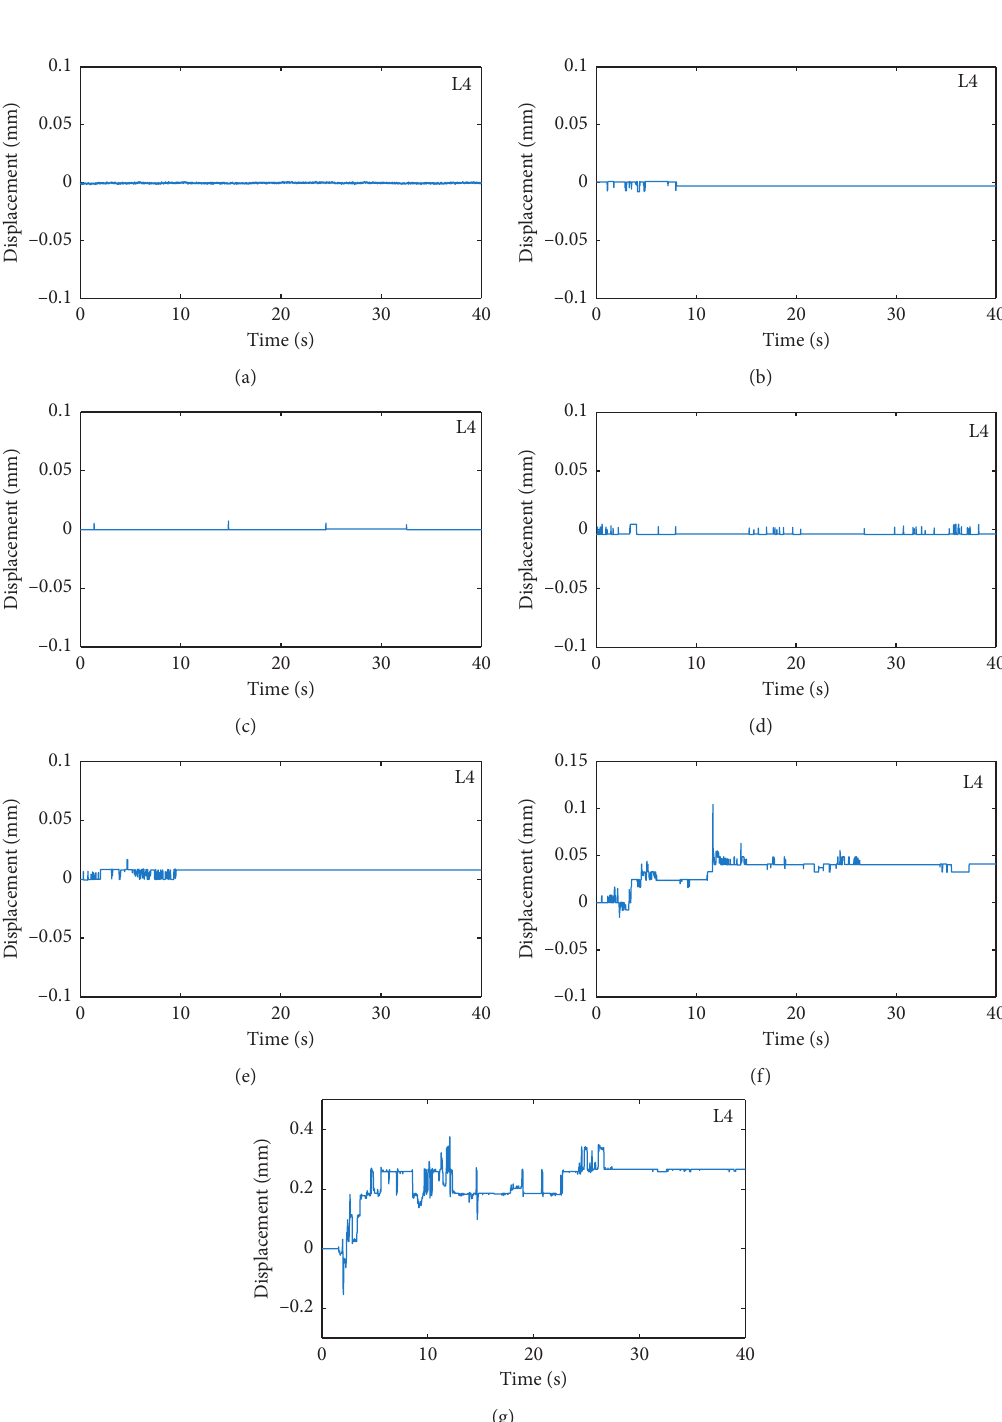
Figure 14: Time history of displacement response of measuring point L4 action by El Centro seismic wave. (a) 0.025g · XY. (b) 0.05g · XY. (c) 0.1g · XY. (d) 0.2g · XY. (e) 0.3g · XY. (f) 0.4g · XY. (g) 0.5g ·